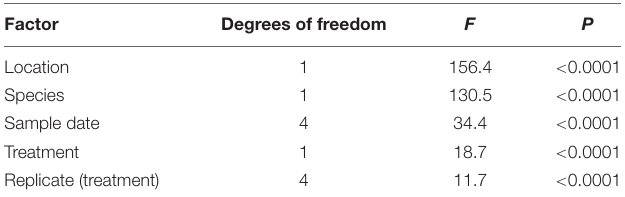
TABLE 2 | Full model ANOVA main effects in the Cedar Fire study with wood stake mass loss as the dependent factor and hydromulch treatment, incubation time, species, and stake location as the independent factors.